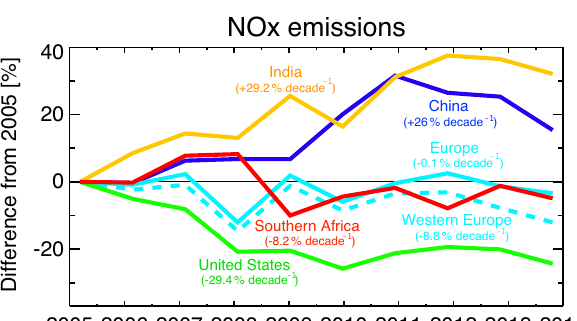
Figure 9. Time series of the difference (in %) of the annual mean a posteriori surface NO x emissions relative to the 2005 emissions in the period 2005–2014 for India (yellow), China (blue), Eu- rope (light blue), western Europe (light blue dashed line), southern Africa (red), and the USA (green).